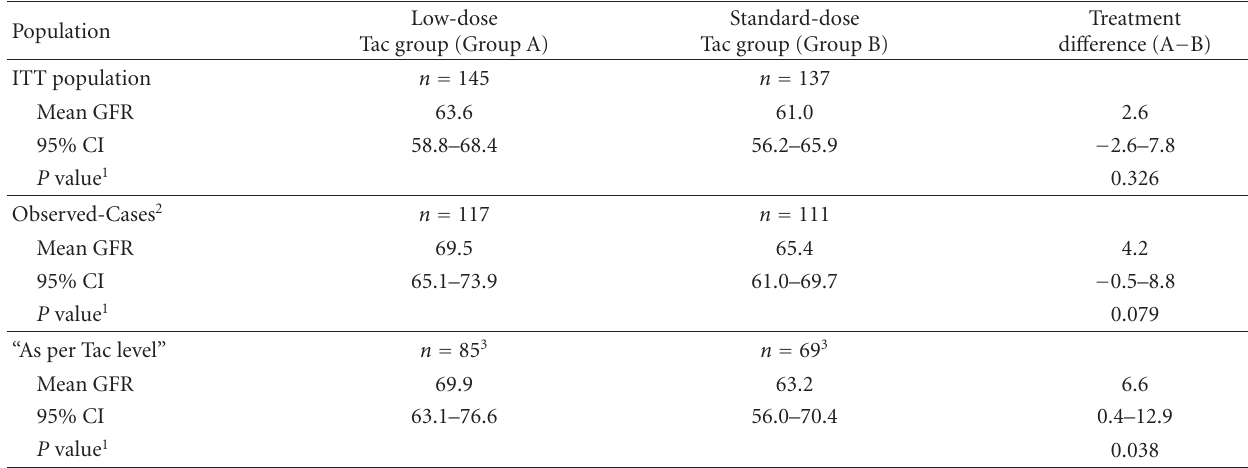
Table 2: Renal function at month 6 assessed by estimated GFR (mL/min/1.73m 2 ) according to Nankivell formula.